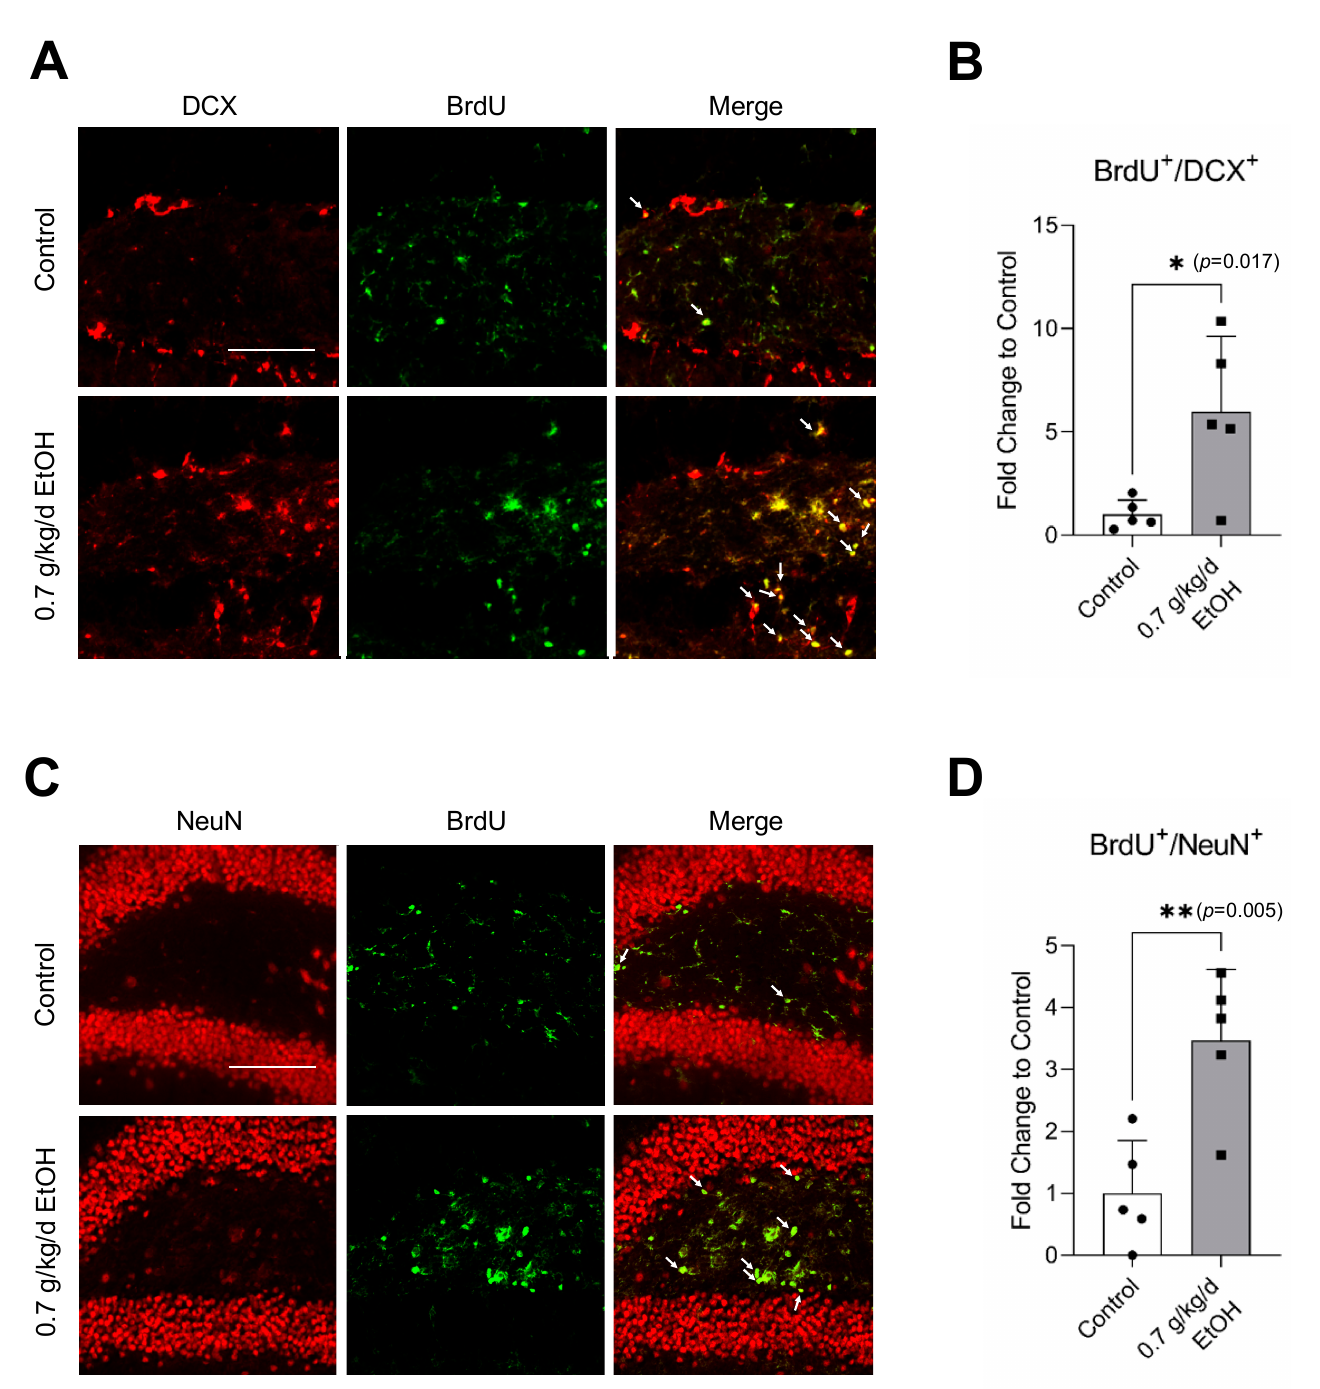
Figure 5. Effect of LAC on postischemic neurogenesis in the DG. ( A ) Representative double staining of BrdU and DCX. Scale bar = 100 µm. ( B ) Values are means ± SD ( n = 5). ( C ) Representative double staining of BrdU and NeuN. ( D ) Values are means ± SD ( n = 5); * p < 0.05; ** p < 0.01 vs. Control. Analyzed using an unpaired t -test.